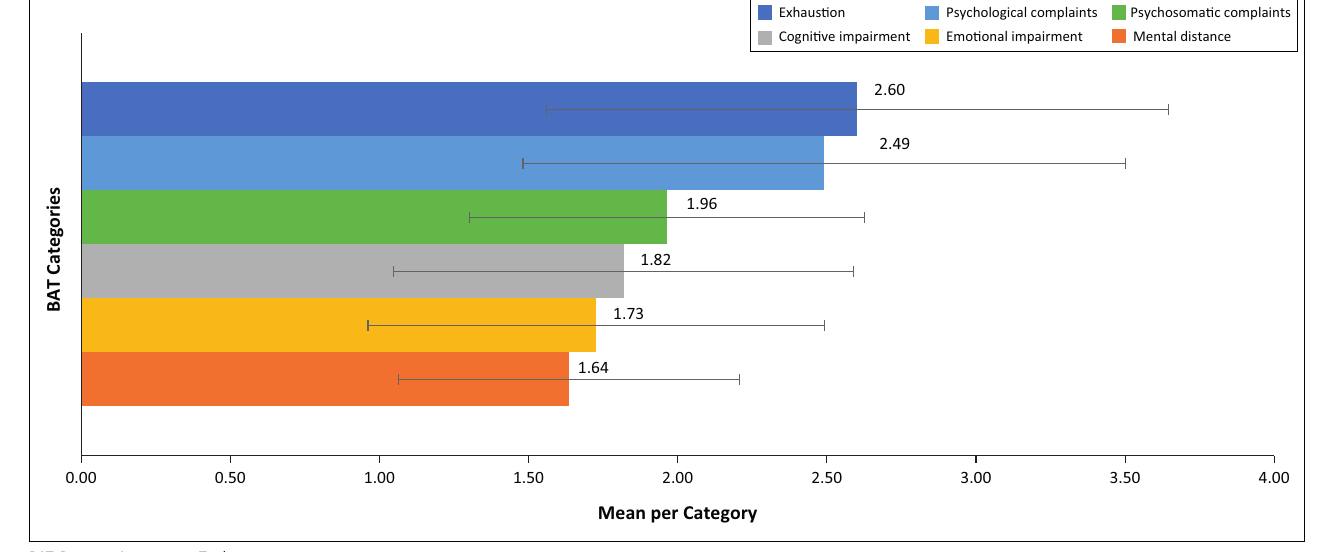
BAT, Burnout Assessment Tool. FIGURE 3: Burnout Assessment Tool data with standard